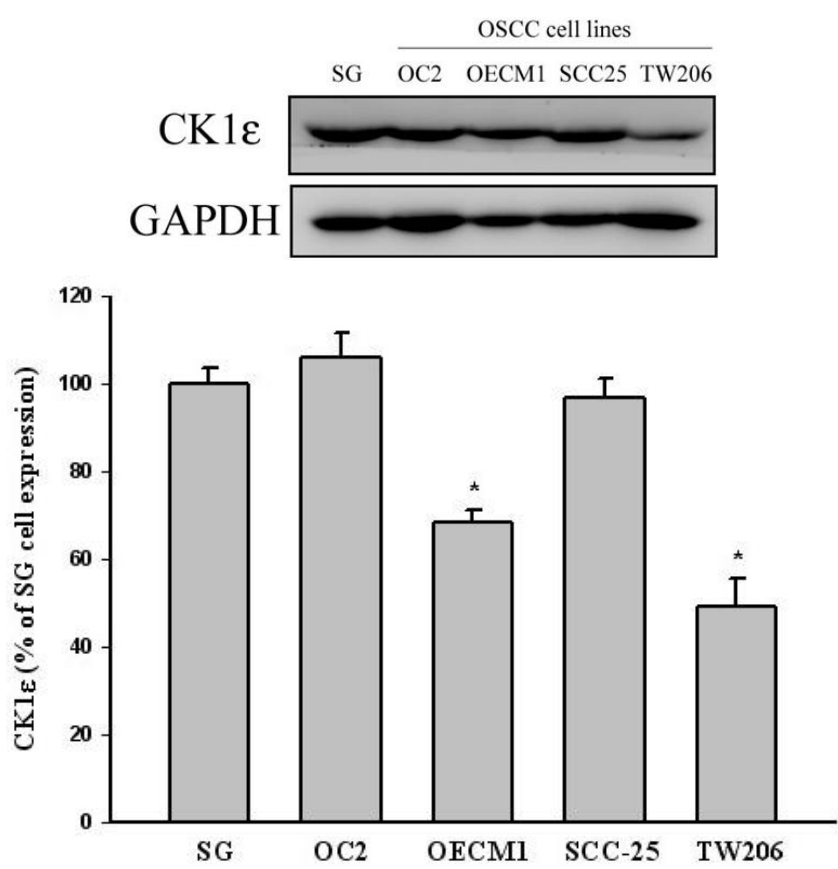
Figure 2. CK1ε expression in normal epithelial cell (SG cell) and four different OSCC cells lines (OC2, OECM1, SCC25 and TW206). Western blot analysis, indicating the high expression of CK1ε in normal epithelial cells and the low expression in OECM1 and TW206 oral cancer cells. * Significant differences from control values with p <